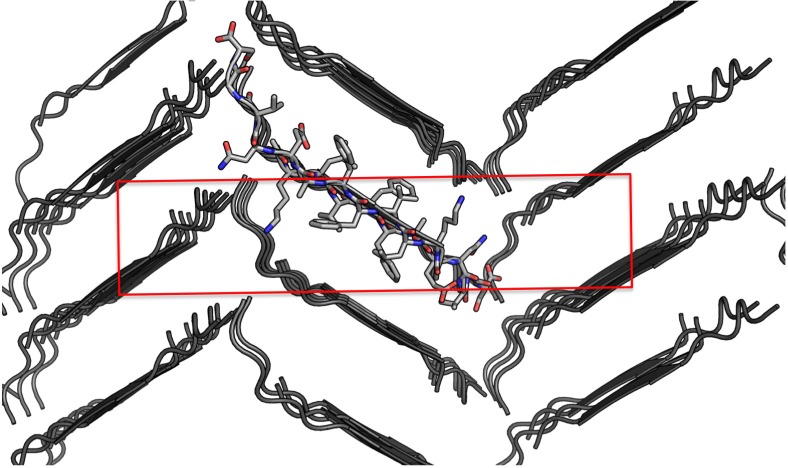
Crystal packing of the Aβ 16–26 D23N atomic structure.View down the ‘a’ axis of the unit cell, outlined in red.